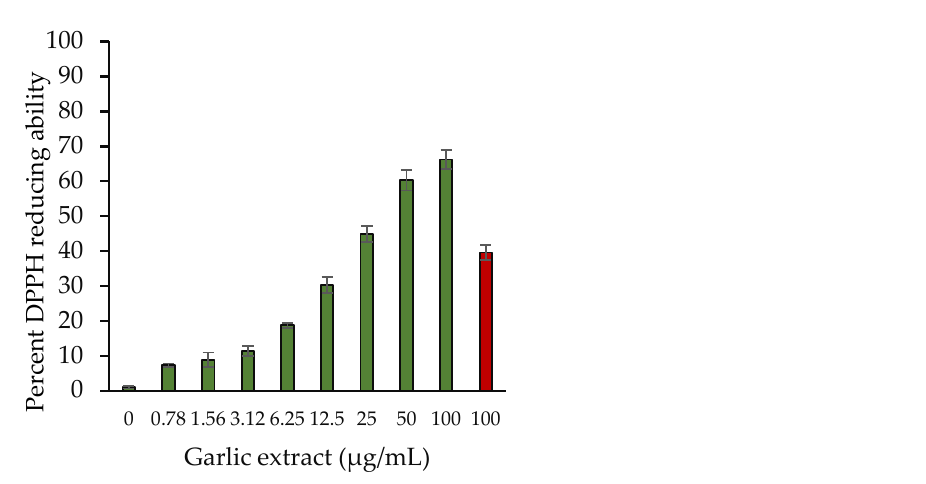
Figure 2. Percentage of free radical reduced vs. aqueous garlic extract concentrations. Various concentrations (0–100 µg/mL) of garlic extracts (green) and 100 µg/mL of ascorbic acid (red). The results are presented as means ± SEM ( n = 3). All the results (0.78–100 µg/mL garlic extract) were statistically significant compared with the sample without extract (0 µg/mL). Comparison between two groups was performed based on t test, and significance was defined as p < 0.05 .